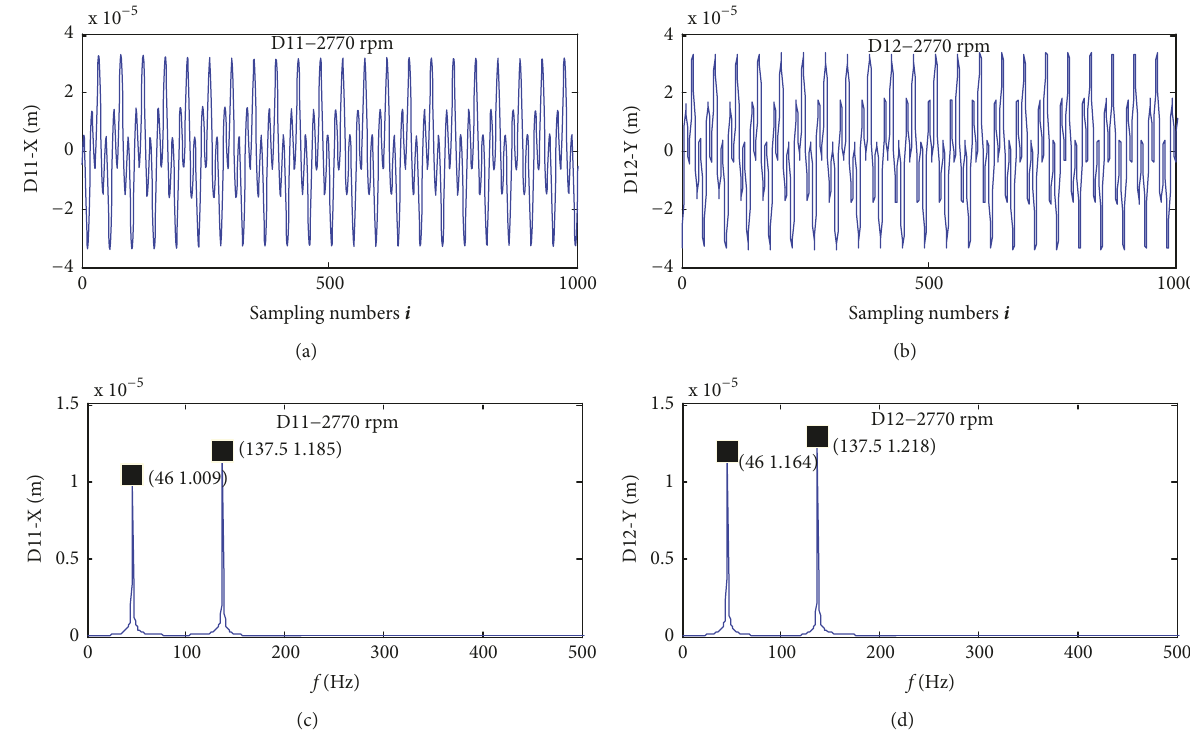
Figure 16: Extracting the frequency spectrums of the first two frequencies of D11 and D12 by PCA algorithm. (a) The time domain of D11. (b) The time domain of D12. (c) The frequency spectrum of D11. (d) The frequency spectrum of D12.